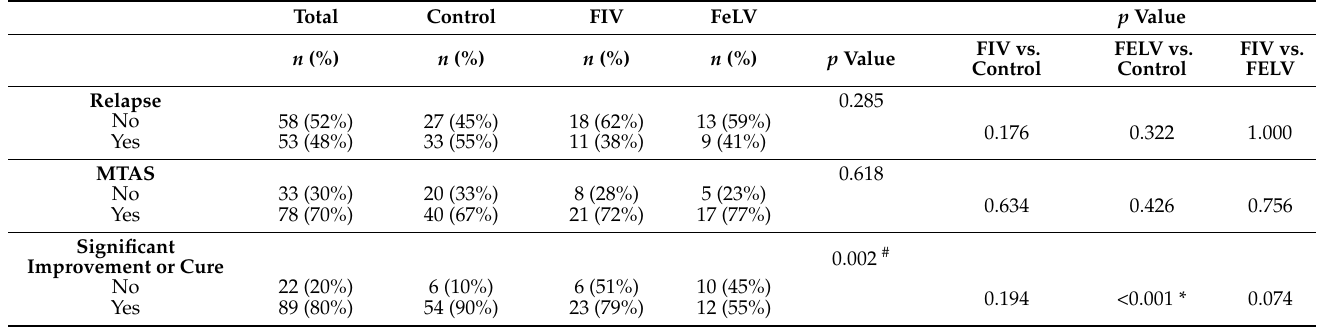
Table 5. Response to